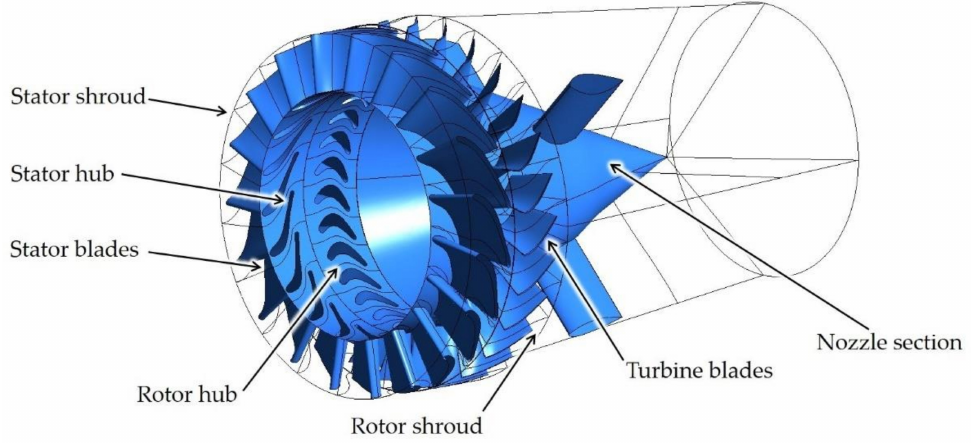
Figure 2. 3D model of the geometry of the turbine and nozzle section of the iSTC-21v jet